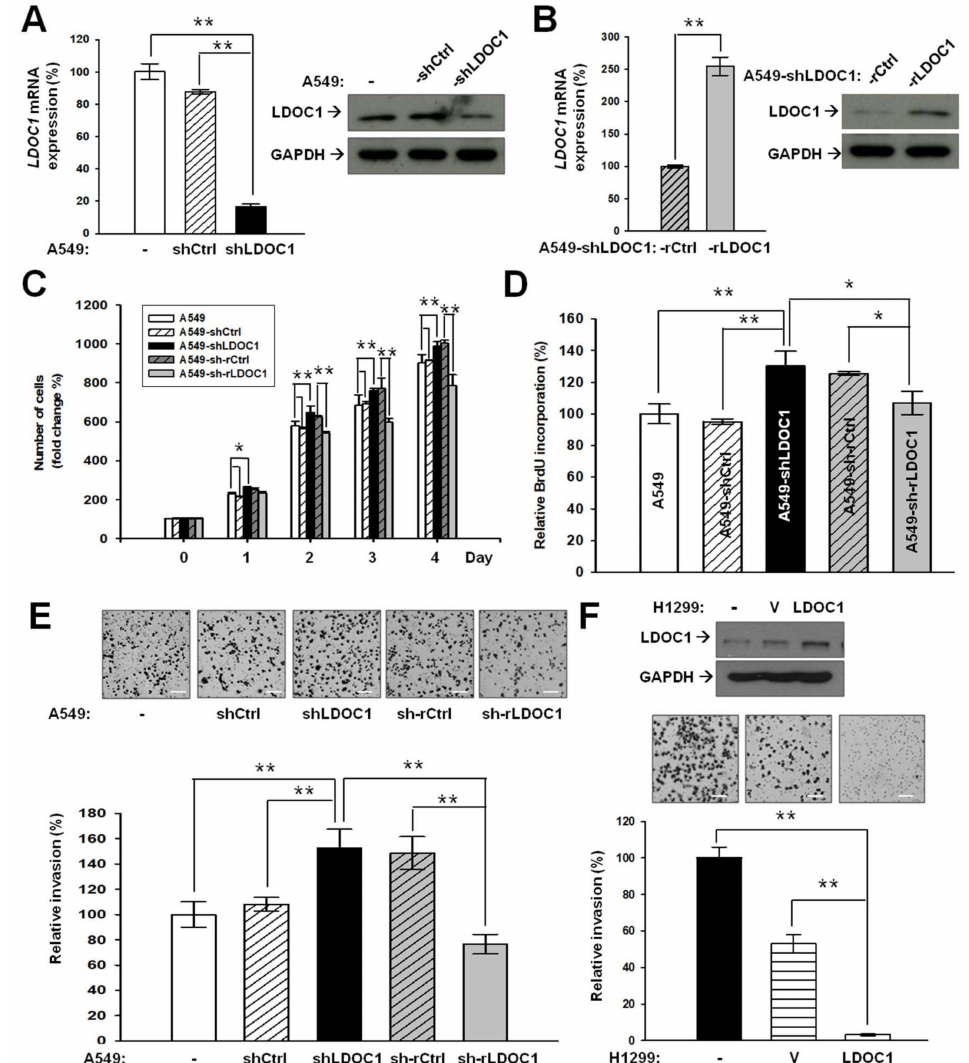
Figure 3. LDOC1 mediates the in vitro malignancy progression in lung cancer cell lines. ( A ) Expression of LDOC1 mRNA and protein were stably suppressed in the A549-derived cell lines. The A549 cell line was transducing lentivirus carrying either scramble control vector (A549-shCtrl) or siRNA targeting LDOC1 (A549-shLDOC1). ( B ) Restoration of LDOC1 expression in A549-shLDOC1-derived cells. A549-shLDOC1 was only transducing GFP-tagged lentivirus vectors (A549-sh-rCtrl) or those fused with an LDOC1 open reading frame (A549-sh-rLDOC1). Expression of LDOC1 mRNA (left) and protein (right) was measured using qPCR and Western blotting analysis, respectively. ( C – F ) Cell proliferation ( C , by MTT), cell cycle progression ( D , by BrdU incorporation assay), and cell invasion ( E , F by Matrigel coated trans-well invasiveness assay) were assessed in the parental A549 cells and the generated A549-derived cell lines ( C – E ) or H1299 ectopic-expressing LDOC1 ( F ). H1299 cells were transduced with lentivirus carrying either open reading frame (ORF) of LDOC1 or empty vector (V, controls). Expression of LDOC1 and GAPDH proteins were measured using Western blotting analysis ( F , upper panels). The number of invading cells was the average of four independent experiments; data were analyzed using a Student’s t -test., where * p < 0.05 and ** p < 0.01. Representative photographs of the invading cells are presented. Scale Bar, 1